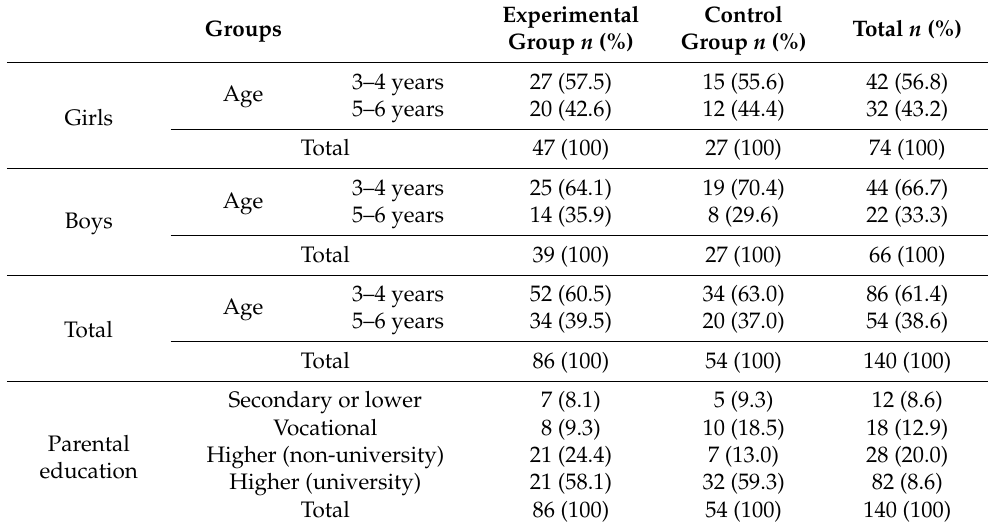
Table 5. Distribution of children in the experimental and control groups by gender, age, and parental education.